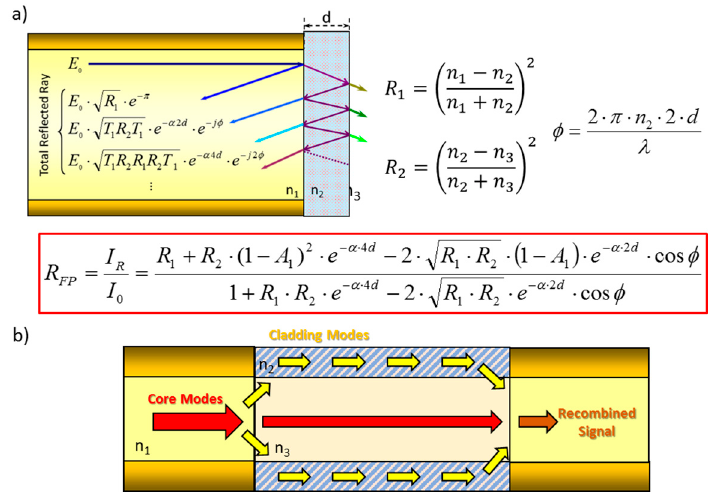
Figure 6. Interferometers used for optical fibre sensors: ( a ) Fabry Perot in reflection sensors, and ( b ) Mach-Zehnder for transmission configuration.